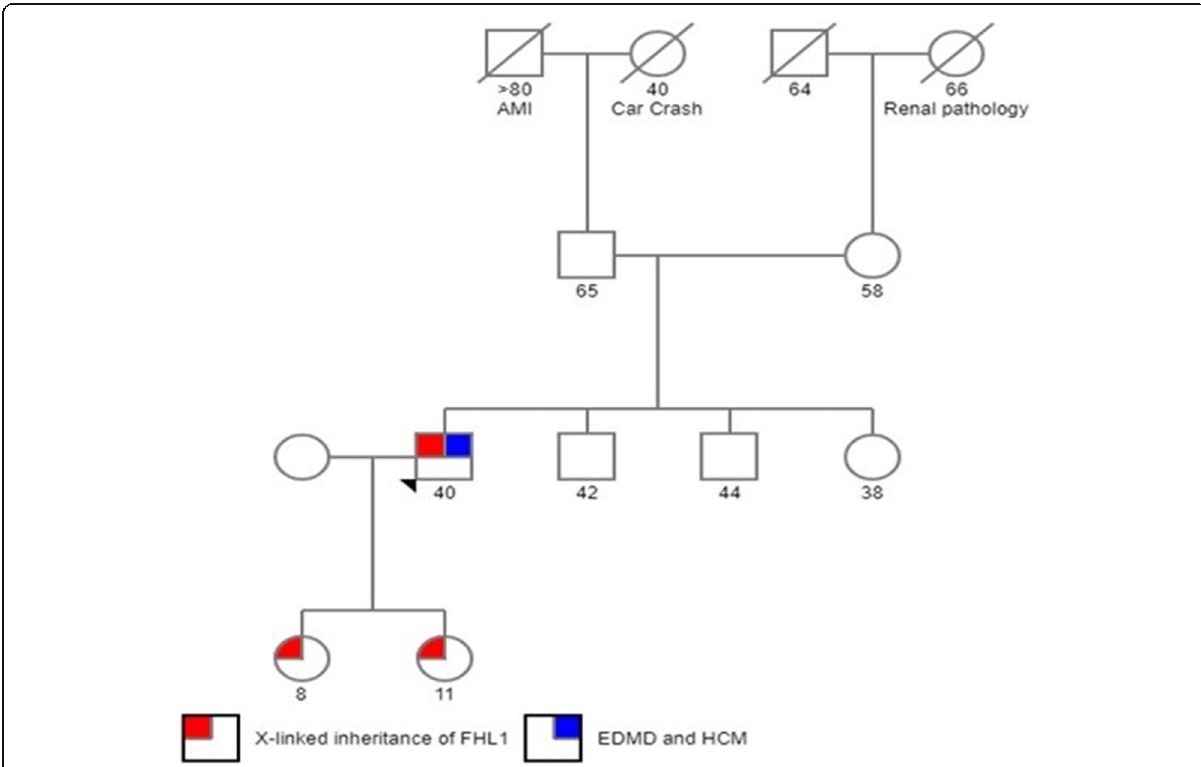
Fig. 5 Pedigree of the family with X-linked